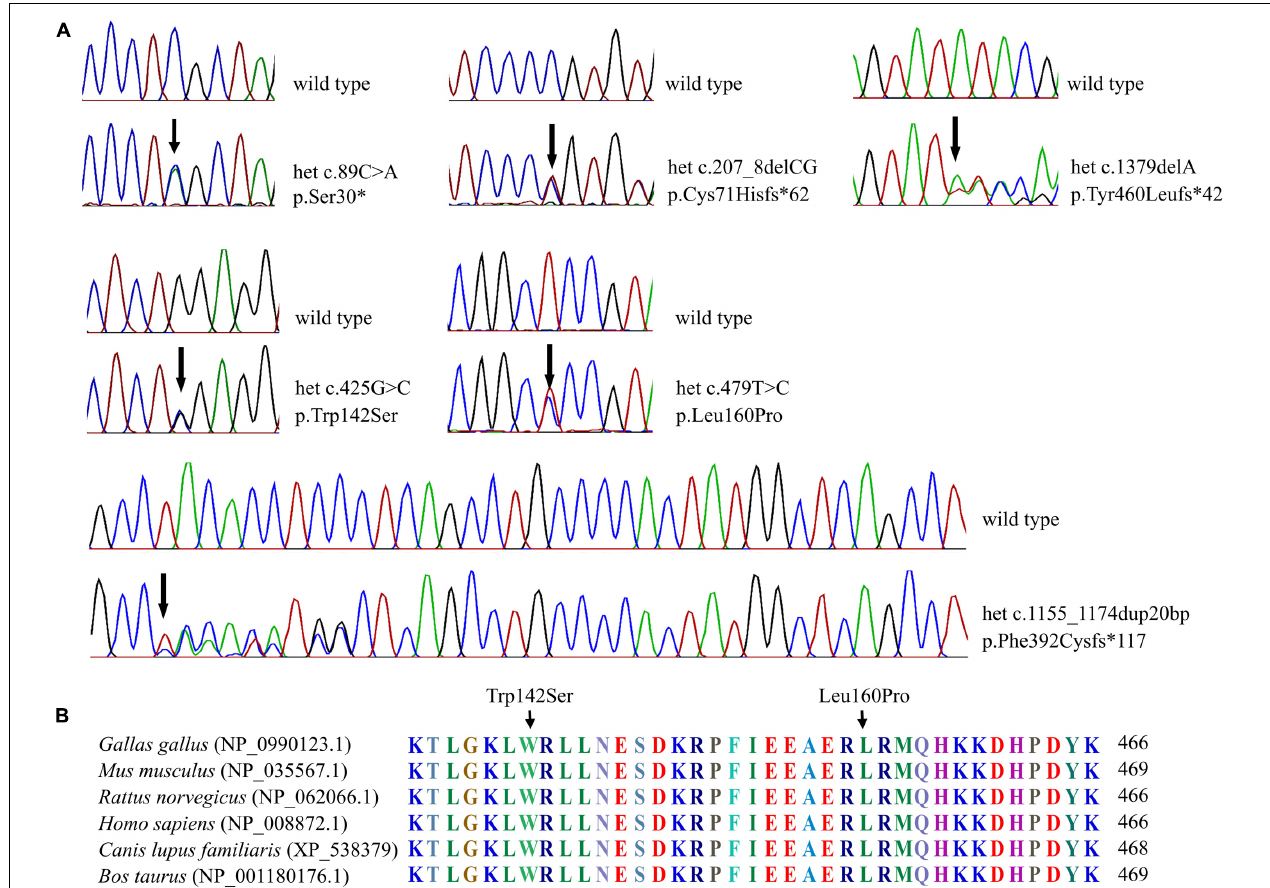
FIGURE 2 | Sequenograms and protein alignment. (A) Sequenograms of the six SOX10 mutations. (B) Protein sequence alignment of vertebrate SOX10; note the highly conserved Trp142 and Leu160 residues across various species.